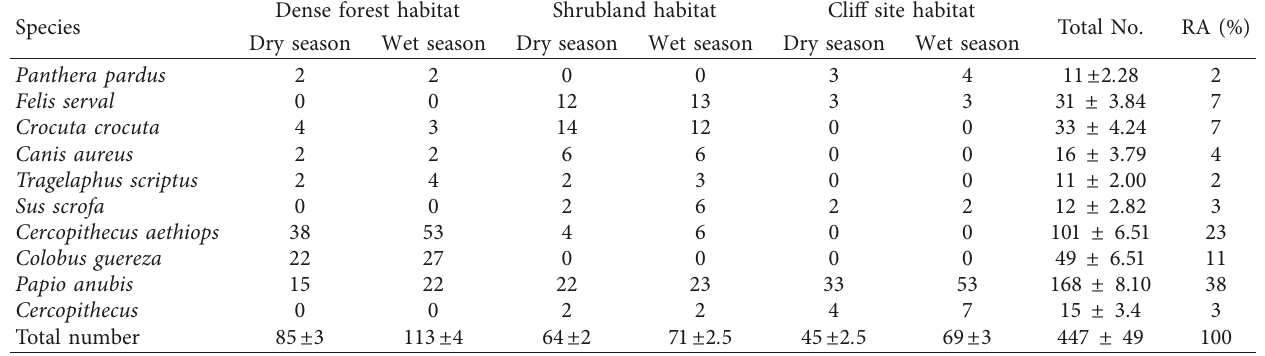
Table 2: Mean abundance of wild mammals among different habitat types with seasons in Tiski waterfalls.